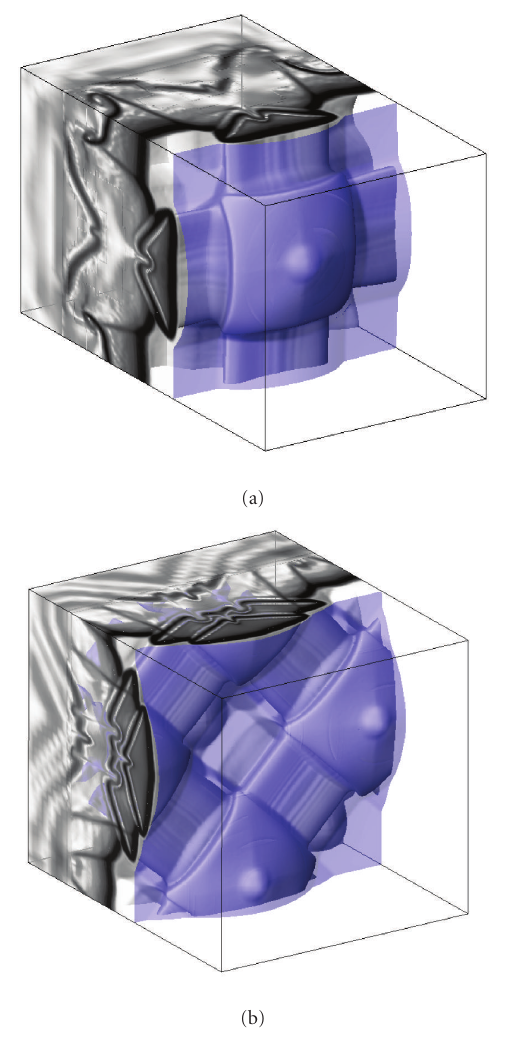
Figure 16: Schlieren plots of Y OH in the first half of a detonation cell for a rectangular (a) and a diagonal (b) structure simulation, 5.0cm < x 1 < 7.0cm.